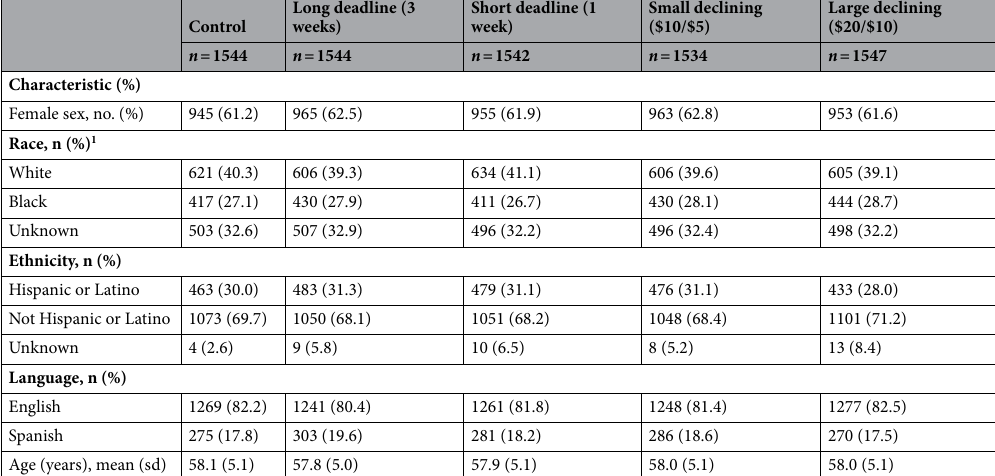
Table 1. Participant characteristics at baseline. 1 Seven participants had no entry for the race variable, and 10 participants either had no entry or refused to provide ethnicity information. 2 The declining-incentive conditions included incentivized deadlines: small declining incentive ($10 for completion within 1 week or $5 for completion within 3 weeks) and large declining incentive ($20 for completion within 1 week or $10 for completion within 3 weeks).